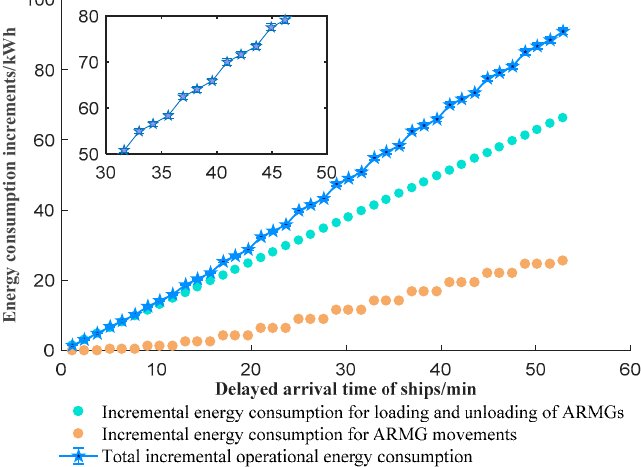
Figure 11. Variation in energy consumption under different ship delay time.